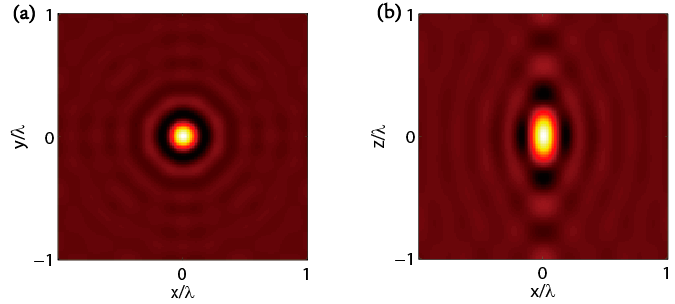
Figure 8. PSF image of TDM in transmission configuration. ( a ) Transverse cut of the PSF at z = 0. ( b ) Longitudinal cut of the PSF at y = 0.